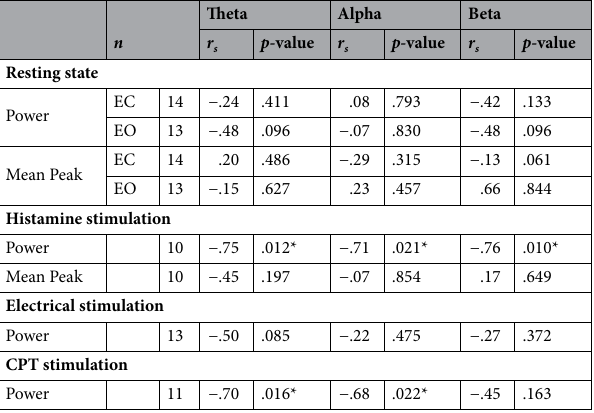
Table 4. Spearman’s correlation coefficient ( r s ) between power and mean peak frequencies during rest, with eyes closed (EC) or eyes open (EO), and stimulation states in theta, alpha, and beta frequency bands with patients’ score on the impact of event scale measuring post-traumatic stress symptoms. * p < .05; ** p < .01; *** p < .001.